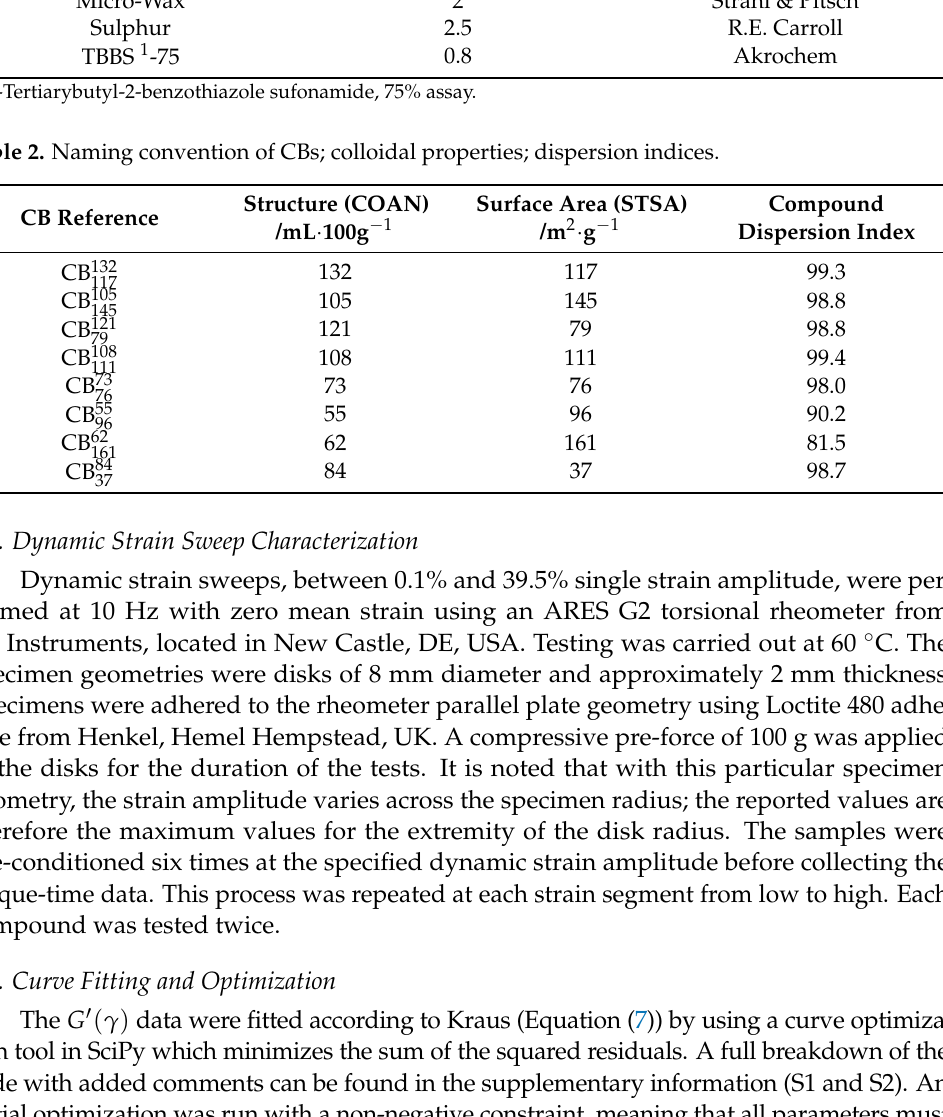
Table 1. Compound formulation. Components Loading/phr Manufacturer of Component NR-SMR CV-60 100 Herman Weber & Co. Various Grades of CB Birla Carbon Stearic Acid PMC Biogenix Anti-ozonant/Antioxidant Micro-Wax 2